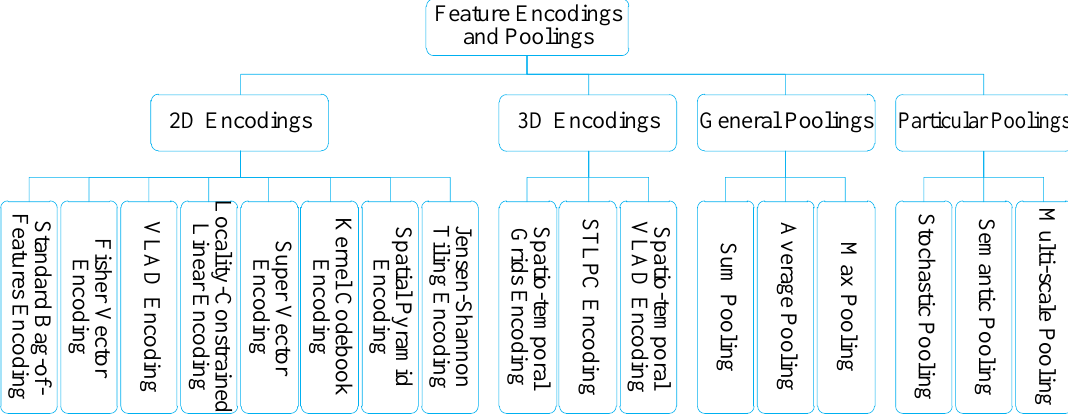
Figure 1. The hierarchical feature encoding and pooling taxonomy of the paper.